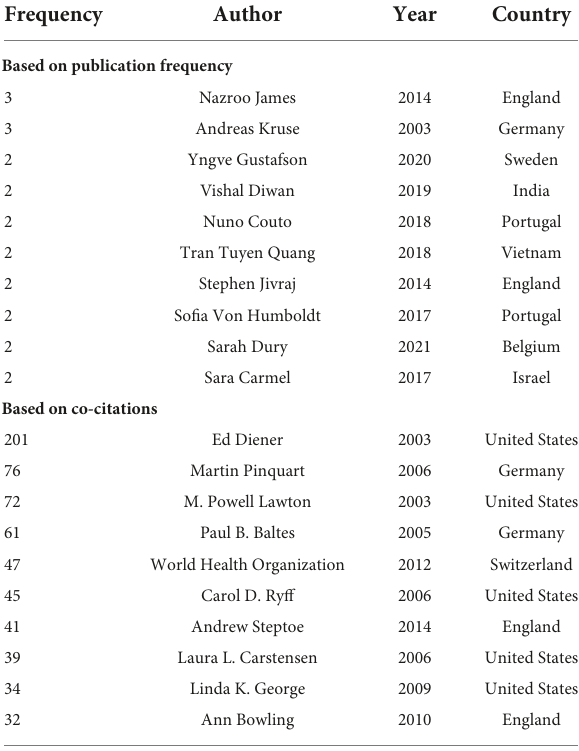
TABLE 3 Top 10 authors for publication frequency and